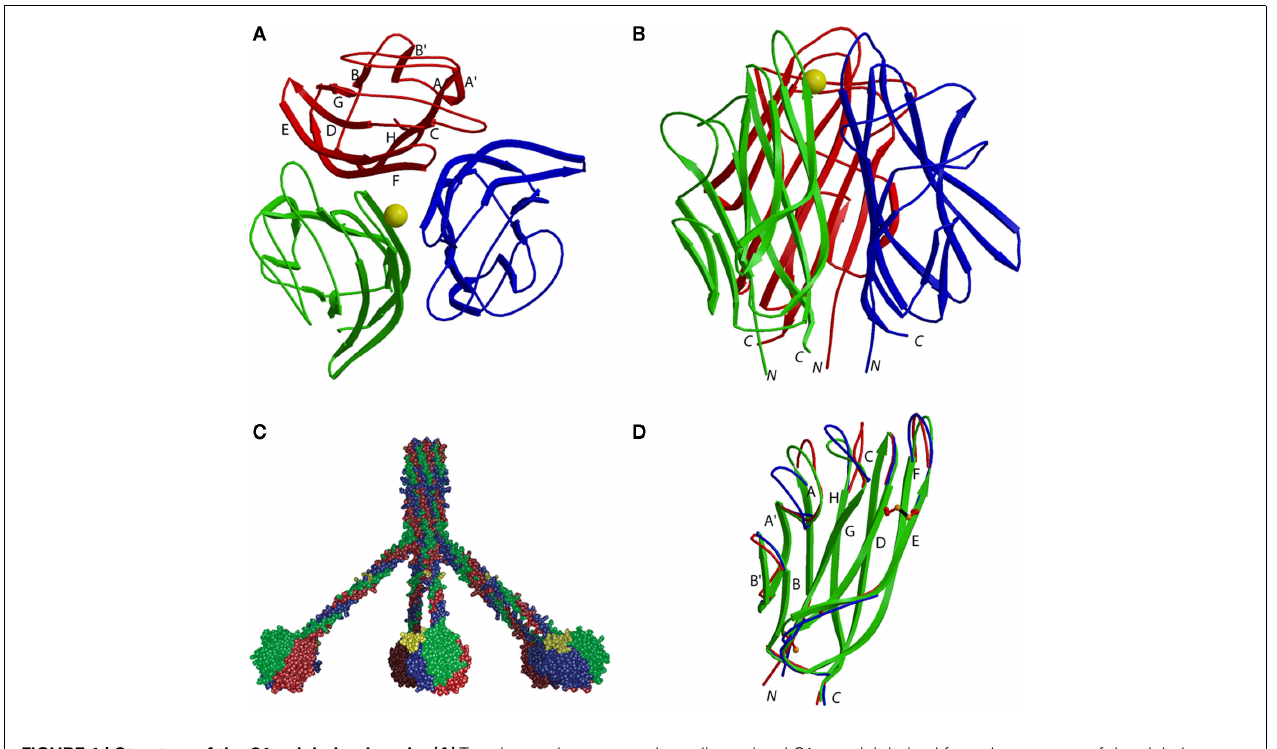
FIGURE 1 | Structure of the C1q globular domain. (A) Top view and (B) side view of the heterotrimeric assembly. Subunits A, B, and C are shown in blue, green, and red, respectively. β -strands are labeled according to the tumor necrosis factor nomenclature, and the Ca 2 + ion is represented as a golden sphere. N and C indicate the N- and C-terminal ends of each gC1q subunit. (C) Side view of the